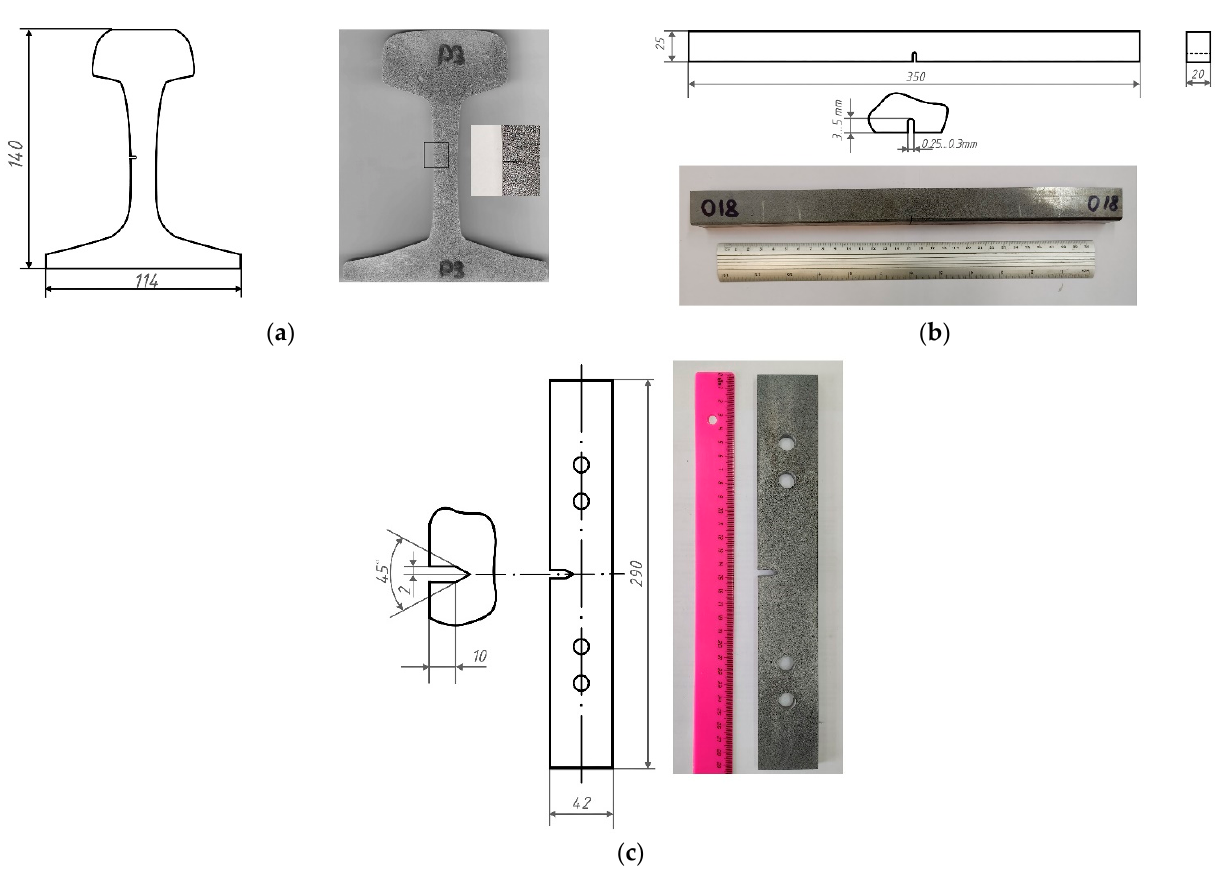
( c ) Figure 2. Experimental setup with rail ( a ), wheelset ( b ), and traction clamp ( c ) samples under in- spection: 1, loading device (punch); 2, inspected sample; 3, DIC system; 4, AE sensors.